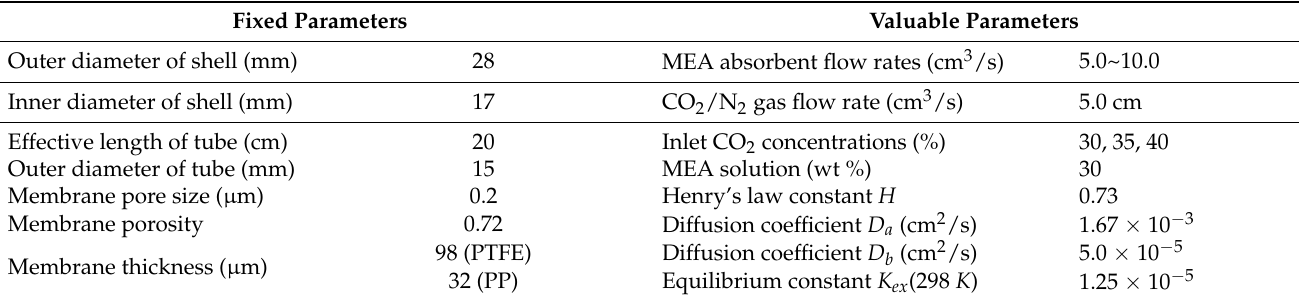
Table 2. Specifications and parameters of the experimental runs.